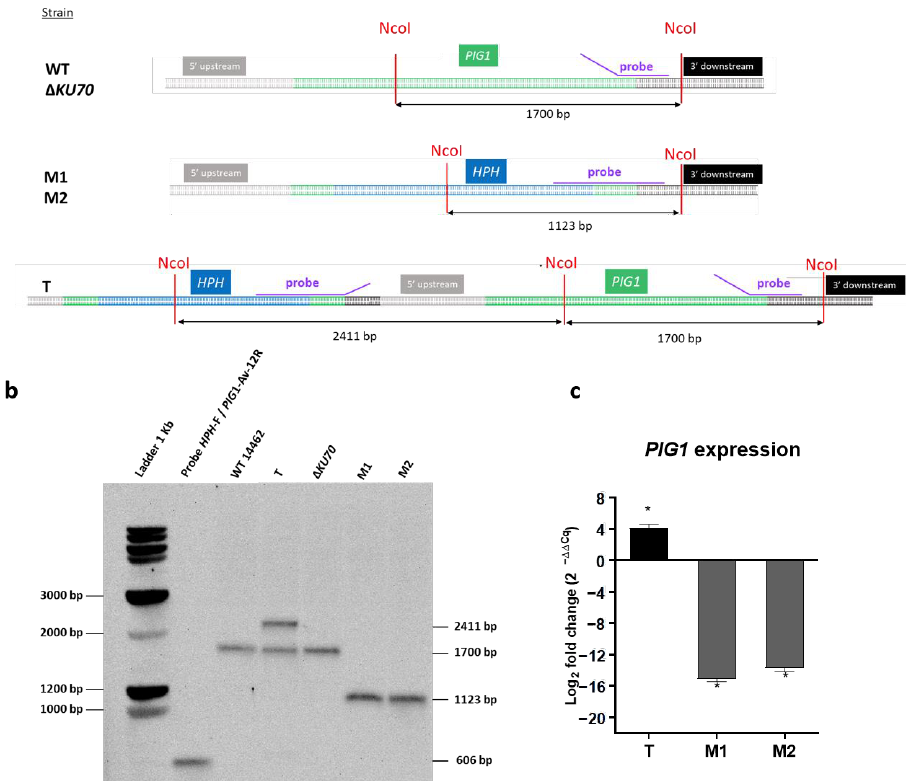
Figure 2. Generation of S. apiospermum Δ PIG1 mutants. ( a ) Restriction map of the S. apiospermum PIG1 locus and strategy for the construction of the disruption cassette. Nco I restriction sites are identified and the purple line indicates the hybridization site of the probe. The size of the expected fragments is indicated by the arrows. ( b ) Southern-blot analysis of PIG1 transformant strains. Genomic DNA of all strains (parental and mutant derivatives) were digested by Nco I and probed with a hybridization probe corresponding to a 600-bp fragment including the PIG1 3′ flanking region and 3′ end of the HPH gene. The expected signals were 1700 bp for the parental strains and 1123 bp for the M1 and M2 mutants. Two unexpected bands were observed for the T strain (2411 bp and 1700 bp), suggesting integration of the repair cassette upstream of the PIG1 gene. ( c ) Expression of PIG1 mRNA by the three HPH-resistant transformants relative to their respective parental strain (i.e., T vs. WT, M1 vs. Δ KU70 , and M2 vs. Δ KU70) . After reverse transcription, mRNA expression was quantified by quantitative PCR. Data were normalized to the expression of the UBC6 and FIS1 housekeeping genes and are representative of four independent experiments. Significant differences are indicated by asterisks: * p ≤ 0.05 (Mann -Whitney test). T: transformant derived from the WT strain; M1 and M2: transformants derived from the Δ KU70 strain.